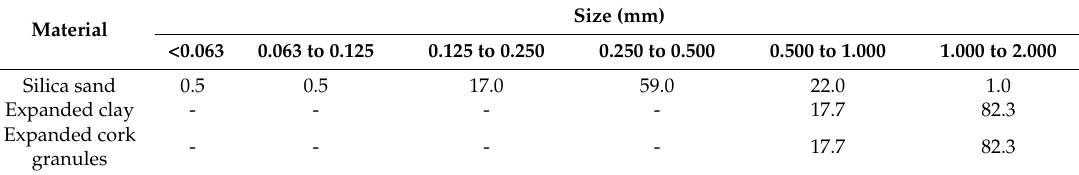
Table 3. Particle size distribution of silica sand, expanded clay, and expanded cork